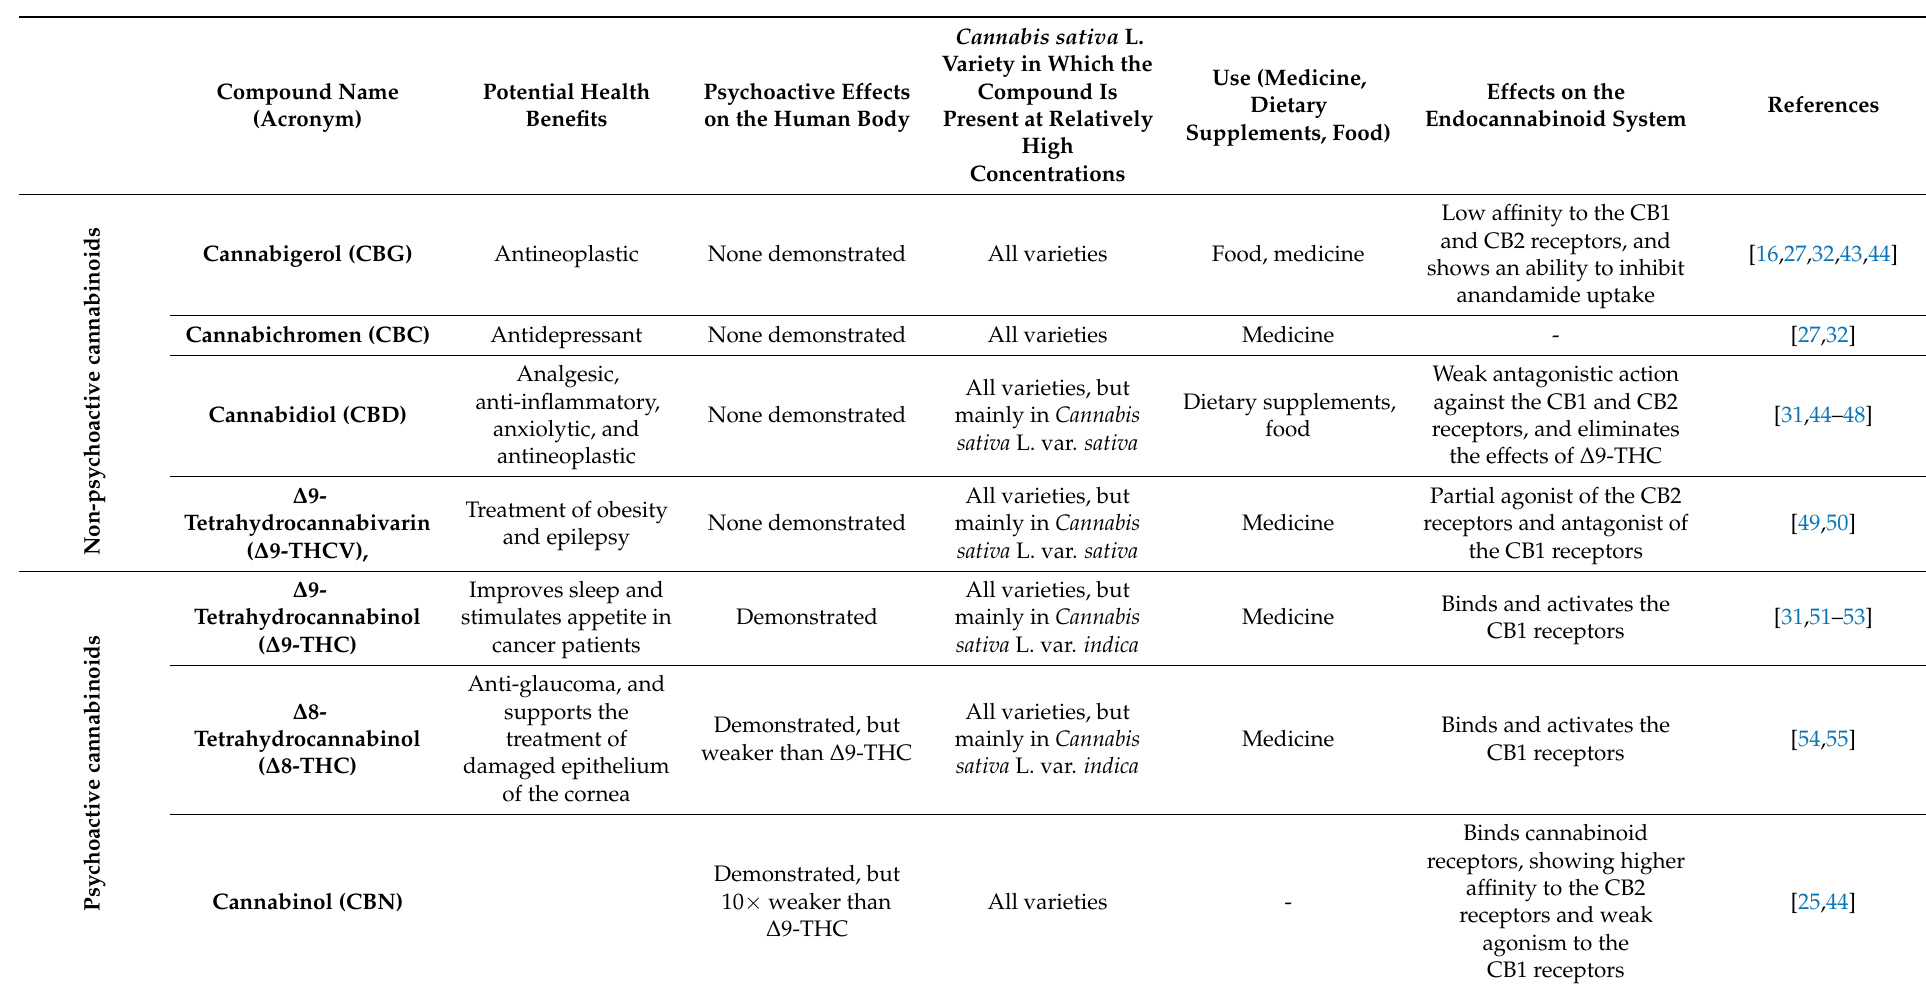
Table 2. Properties of selected neutral